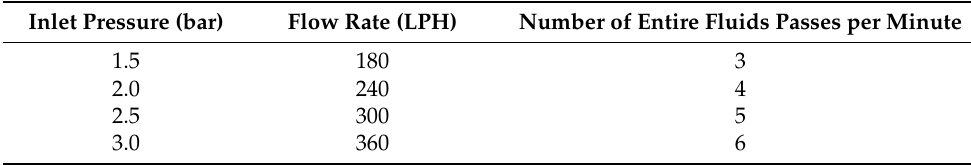
Table 1. Flow characteristics of